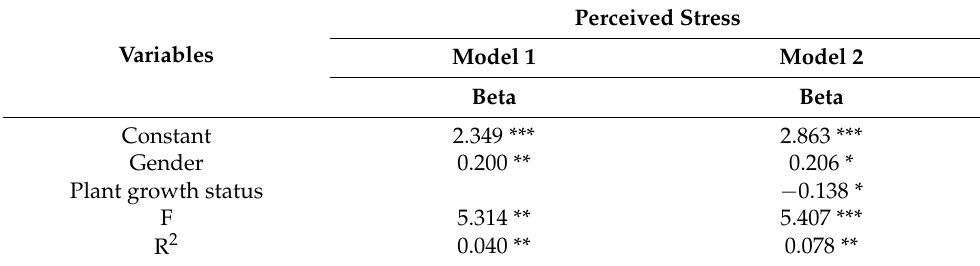
Table 4. Regression analysis results of plant growth status predicting perceived stress.